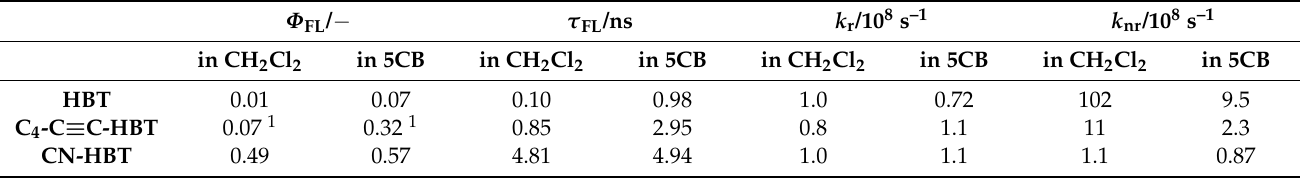
Table 1. Fluorescent quantum yield Φ FL , fluorescence lifetime τ FL , and radiative rate constant k r and nonradiative rate constant k nr for HBT, C 4 -C ≡ C-HBT , and CN-HBT in CH 2 Cl 2 (5 × 10 –5 M) and 5CB (1/99 wt/wt) ( λ Ex = 365